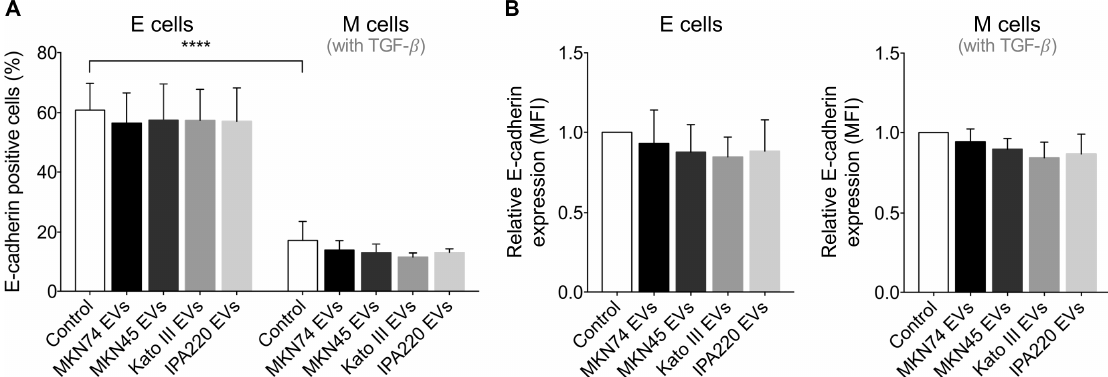
Figure 4. GC-EVs do not modulate membrane E-cadherin expression of epithelial and mesenchymal cells. ( A ) Percentage of E-cadherin-positive cells in non-treated (control) and treated epithelial and mesenchymal cells were assessed by flow cytometry. Graph represents the mean ± standard deviation of three independent experiments (**** p ≤ 0.0001, Two-way ANOVA with Tukey’s multiple comparisons test); ( B ) intensity of E-cadherin surface expression of non-treated (control) and treated epithelial and mesenchymal cells was assessed by flow cytometry. Graph represents the mean ± standard deviation of three independent experiments, and data were normalized to each respective control cell. TGF β 1 was maintained in M cultures (control and treated M cells).